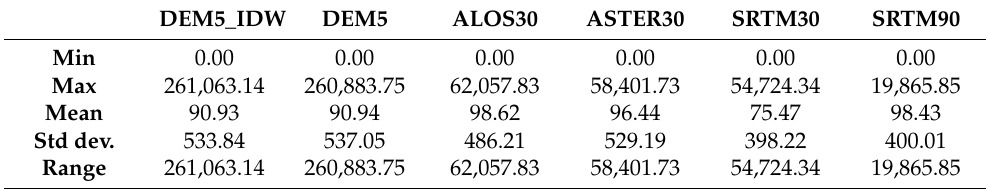
Table 9. The descriptive statistics of the annual soil loss (SE) (LS: MIT method) for each DEM. DEM5_IDW